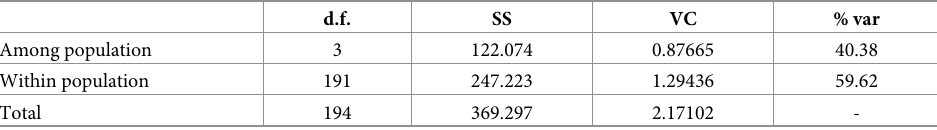
Table 4. AMOVA analysis of ALD and different mallard clades.